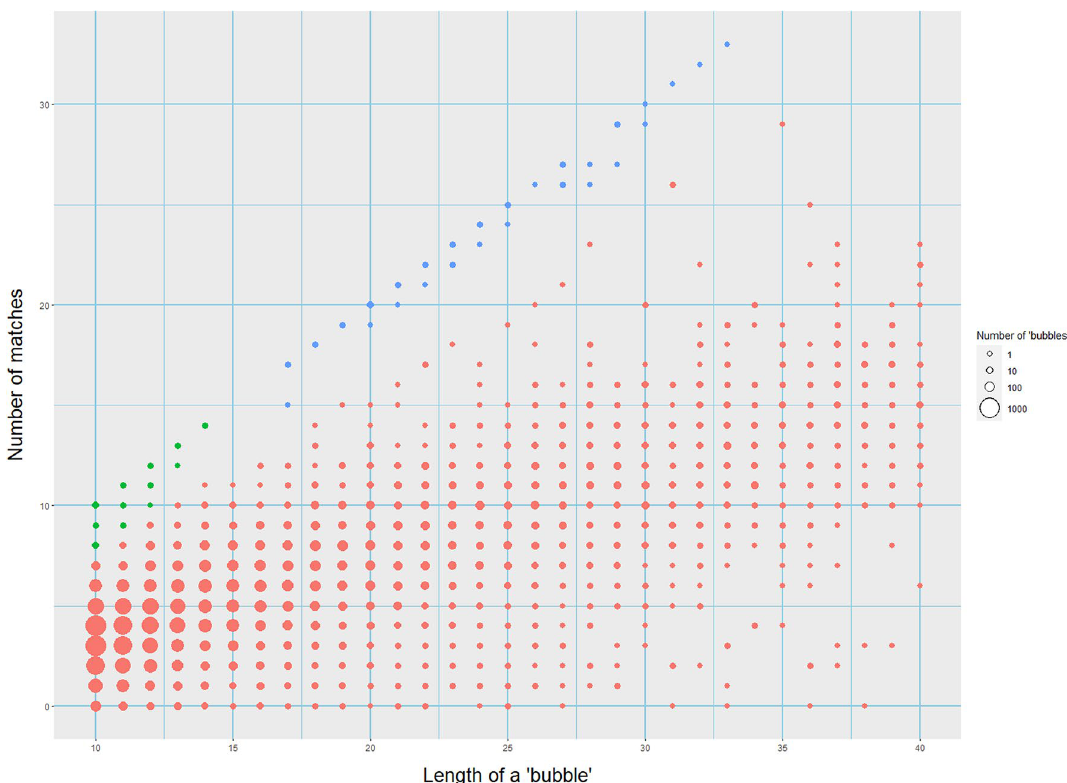
Figure 1. Microinversions in the human-chimpanzee genome alignment. The x-axis corresponds to the length of a “bubble” from 10 to 40 nucleotides; the y-axis corresponds to the number of matches between the reverse complement of chimpanzee DNA sequence and the corresponding human DNA sequence. Blue circles correspond to microinversions that we consider to be definite, green circles—likely microinversions. Sizes of circles corresponds to the number of